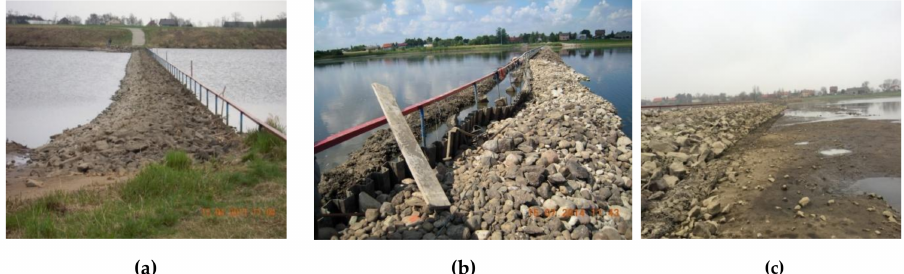
Figure 3. Stare Miasto reservoir in the Powa river: ( a ) The internal dam in 2011; ( b ) the internal dam destroyed after the flood wave propagation in 2014; ( c ) the uncovered reservoir bottom near the internal dam (author: J. Wicher-Dysarz).